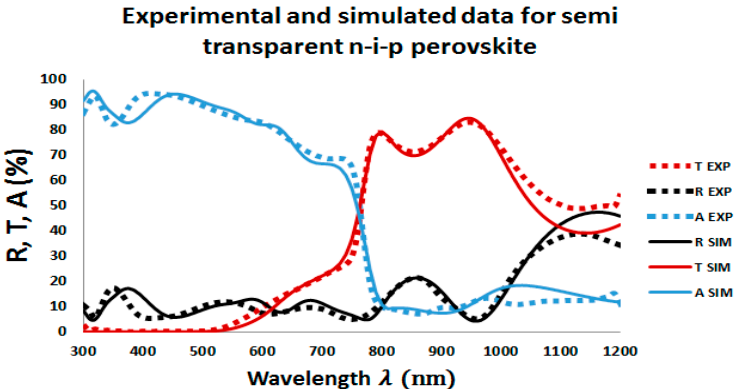
Figure 2. Measured and simulated reflectance (R), transmittance (T), and absorptance (A) spectra of semitransparent MAPbI3 solar cell with the architecture glass/ITO-front/ITO-front-roughness/SnO2/PCBM/MAPbI3/MAPbI3-roughness/spiro-OMeTAD/ITO-rear/ITO-rear-roughness. The dashed lines represent measurements on the actual device and solid lines represent transfer-matrix-based simulations.